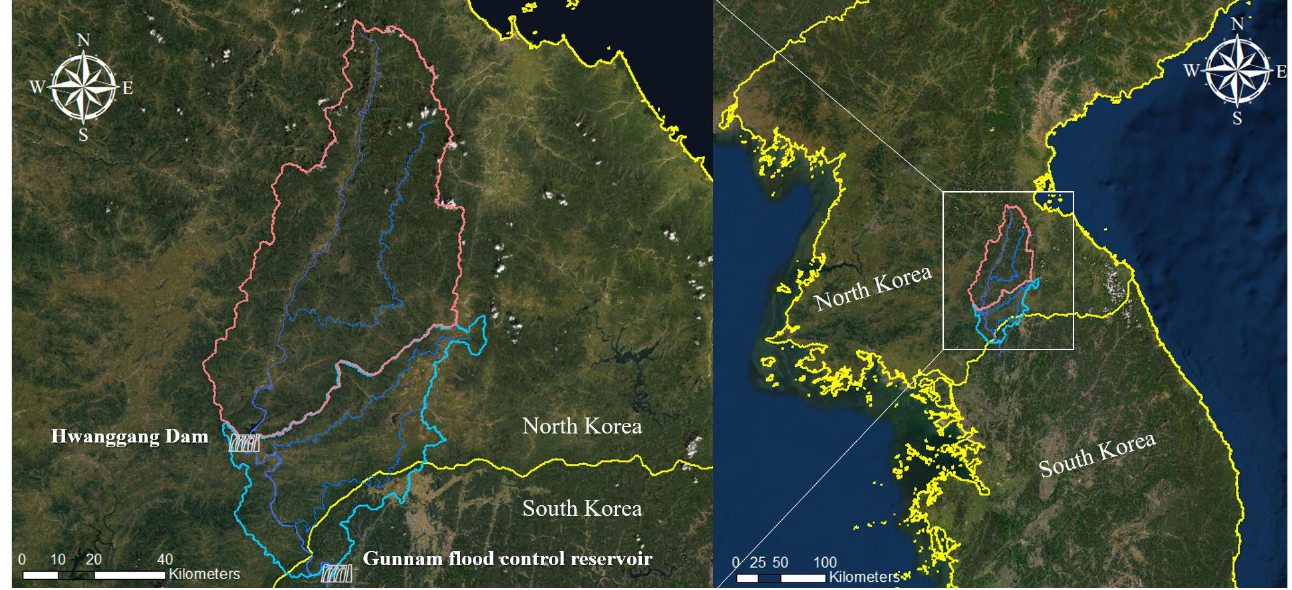
Figure 1. The location of the Imjin River basin including the Hwanggang Dam and Gunnam Flood Control Reservoir.